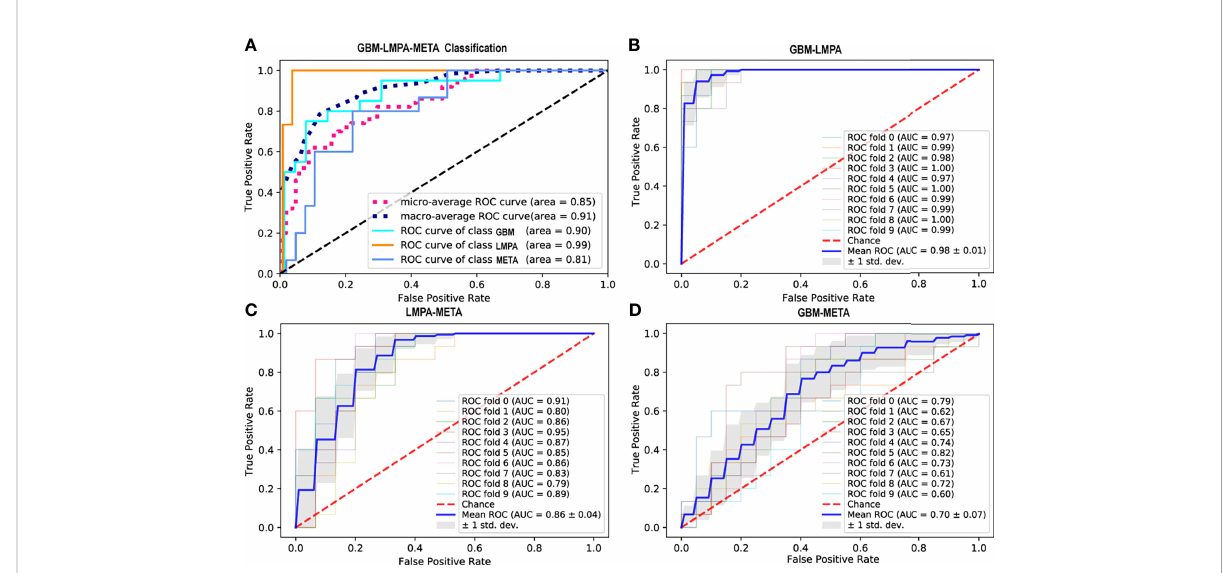
FIGURE 4 Receiver operating characteristic (ROC) curves for different classi fi cation tasks. (A) ROC curve of the Adaboost classi fi er for the differentiation of glioblastoma (GBM), metastases (META), and primary central nervous system lymphoma (LMPA) (using the top 20 features from the traditional and quantitative peritumoral regions). The two dashed lines represent the micro-average and macro-average ROC curves, respectively. (B – D) ROC curve of the best classi fi er for the binary classi fi cation between GBM and LMPA, LMPA and META, as well as GBM and META, respectively. Each solid line represents the ROC curve of each fold cross-validation. The thick blue line represents the mean ROC curve (with the standard deviation represented by the gray